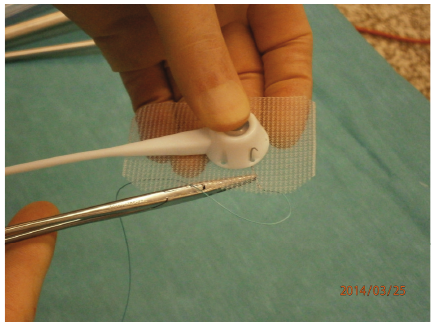
Table 2: Statistical significance comparing fixation